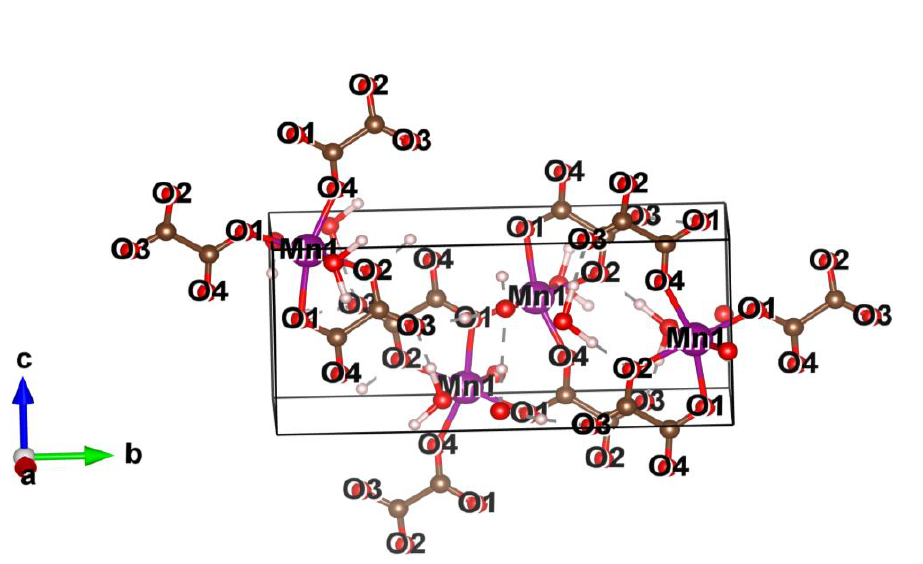
O .2H O: a) side view b) 2 4 2